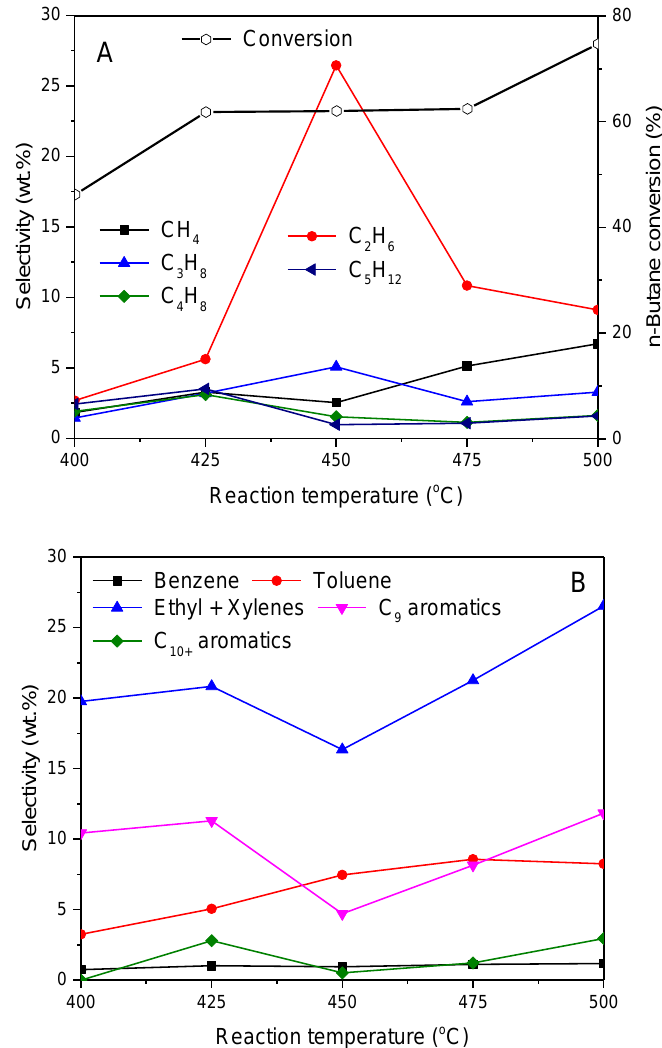
Figure 7. Effect of reaction temperature on n-butane conversion, selectivity to aliphatics ( A ), and selectivity to aromatics ( B ) over Pt Mo IMP. The C 5 H 10 in the aliphatics and C 10 H 14 in the aromatics were used to simplify the molar calculations for the C 5 aliphatics and C 10+ aromatics.